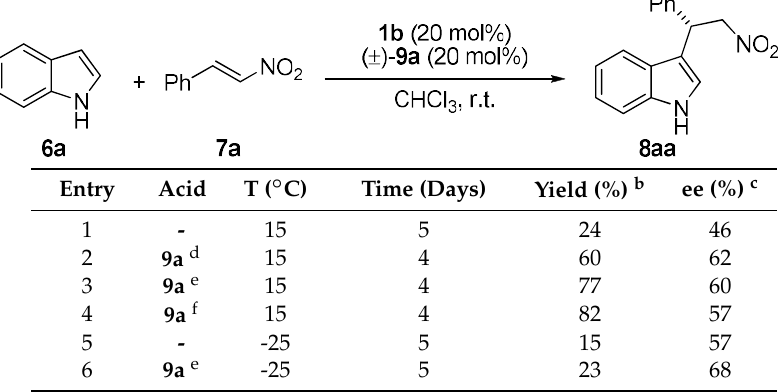
Table 2. Effect of temperature of model reaction. a